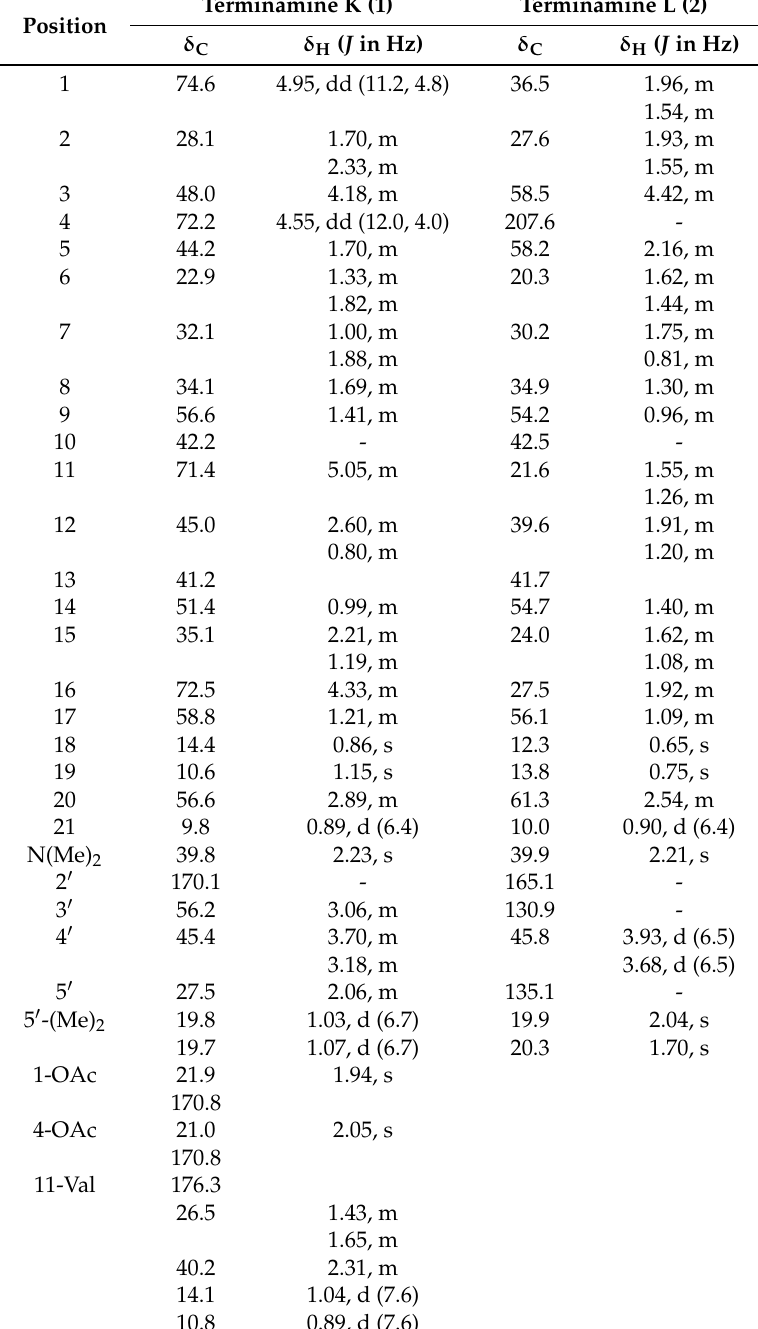
Table 1. NMR Spectroscopic data (400 MHz, CDCl 3 ) for Terminamine K ( 1 ) and Terminamine L ( 2 ). Terminamine K Position